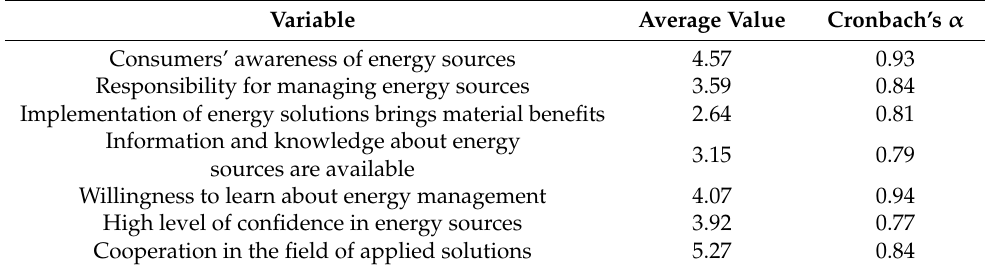
Table 2. Mean values and Cronbach’s α